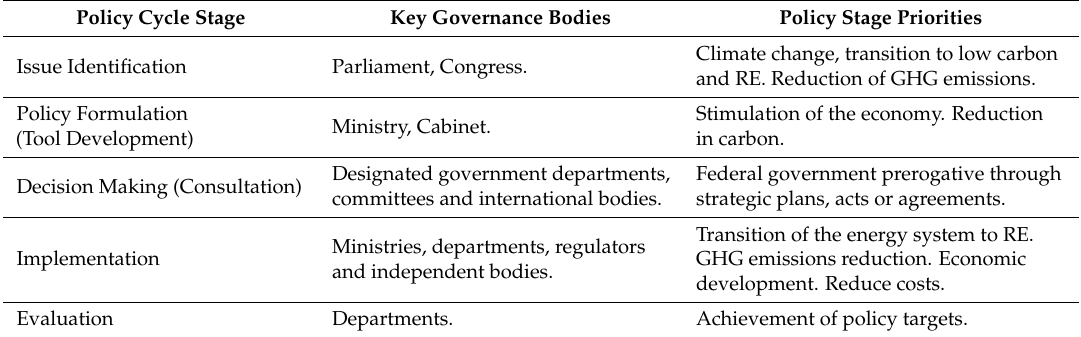
Table 9. Summary of policy cycle, governance, priorities and sustainability factor